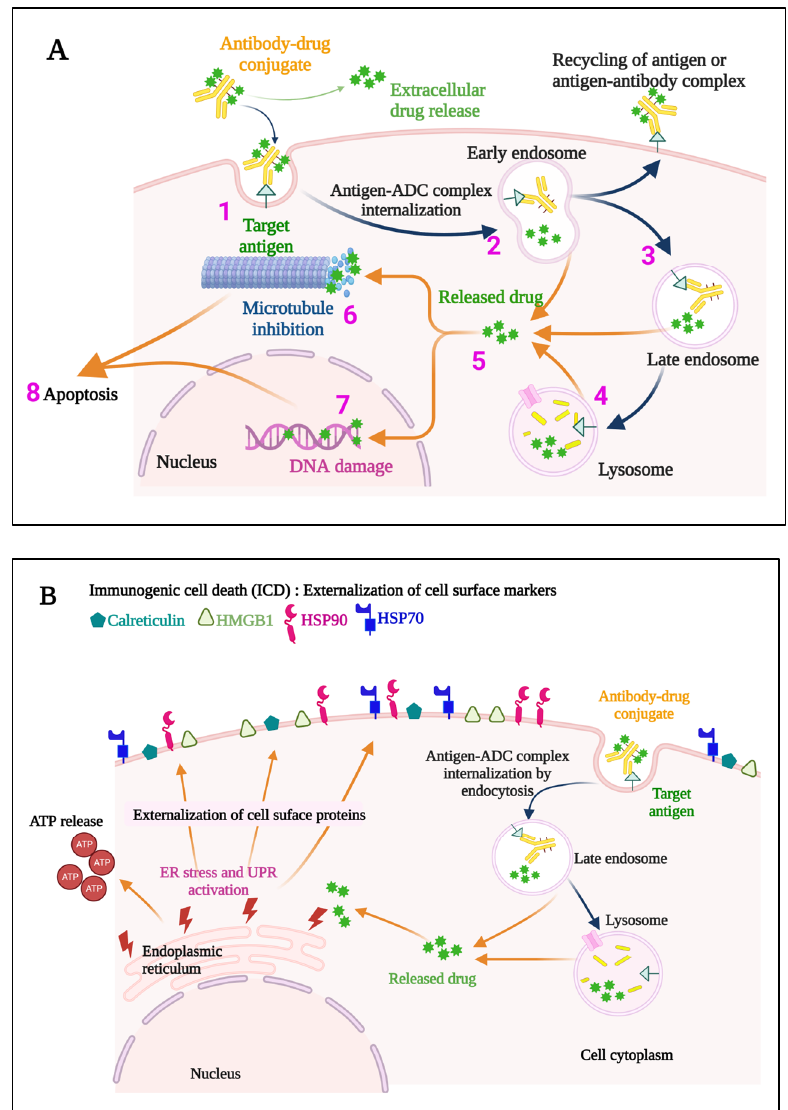
Figure 3. A representation of the events occurring both at the cell membrane and intracellularly that contribute to the direct cytotoxic mechanisms of action of an ADC ( A ) is provided. The ADC binds to the specific target antigen on the cell surface (1), the ADC-antigen complex is internalized (2), and endosome/lysosome mediated processing (3,4) results in the release of the cytotoxic payload into the cytosol (5). If an anti-microtubule agent is the payload, aberrant spindle formation may occur causing cell cycle arrest and apoptosis (6), while DNA intercalators cause DNA damage (7), ultimately leading to apoptosis of the cell (8). Some ADCs also induce immunogenic cell death (ICD) ( B ), which elicits a host immune anti-tumor response. Hallmarks of ICD include externalization of Calreticulin, and Heat shock protein 90 (HSP90) and HSP70, externalization and later release of High mobility group box 1 (HMGB1), and release of ATP. ER, endoplasmic reticulum; UPR, unfolded protein response; ADC, antibody–drug conjugate.